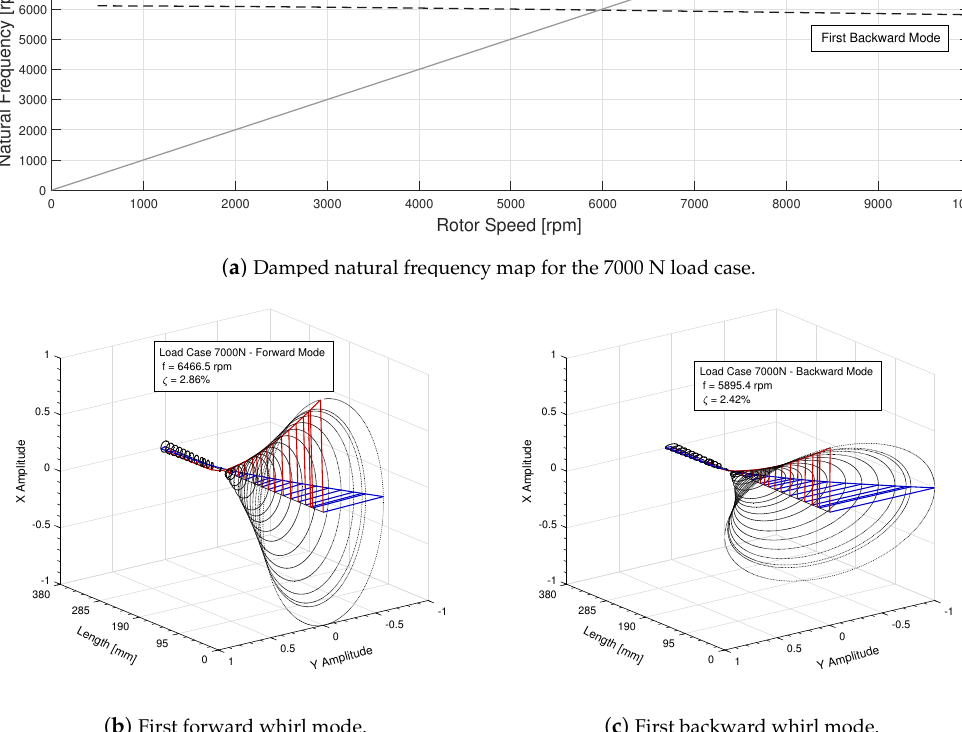
Figure 6. Results of the performed damped eigenvalue analysis for the 7000 N load